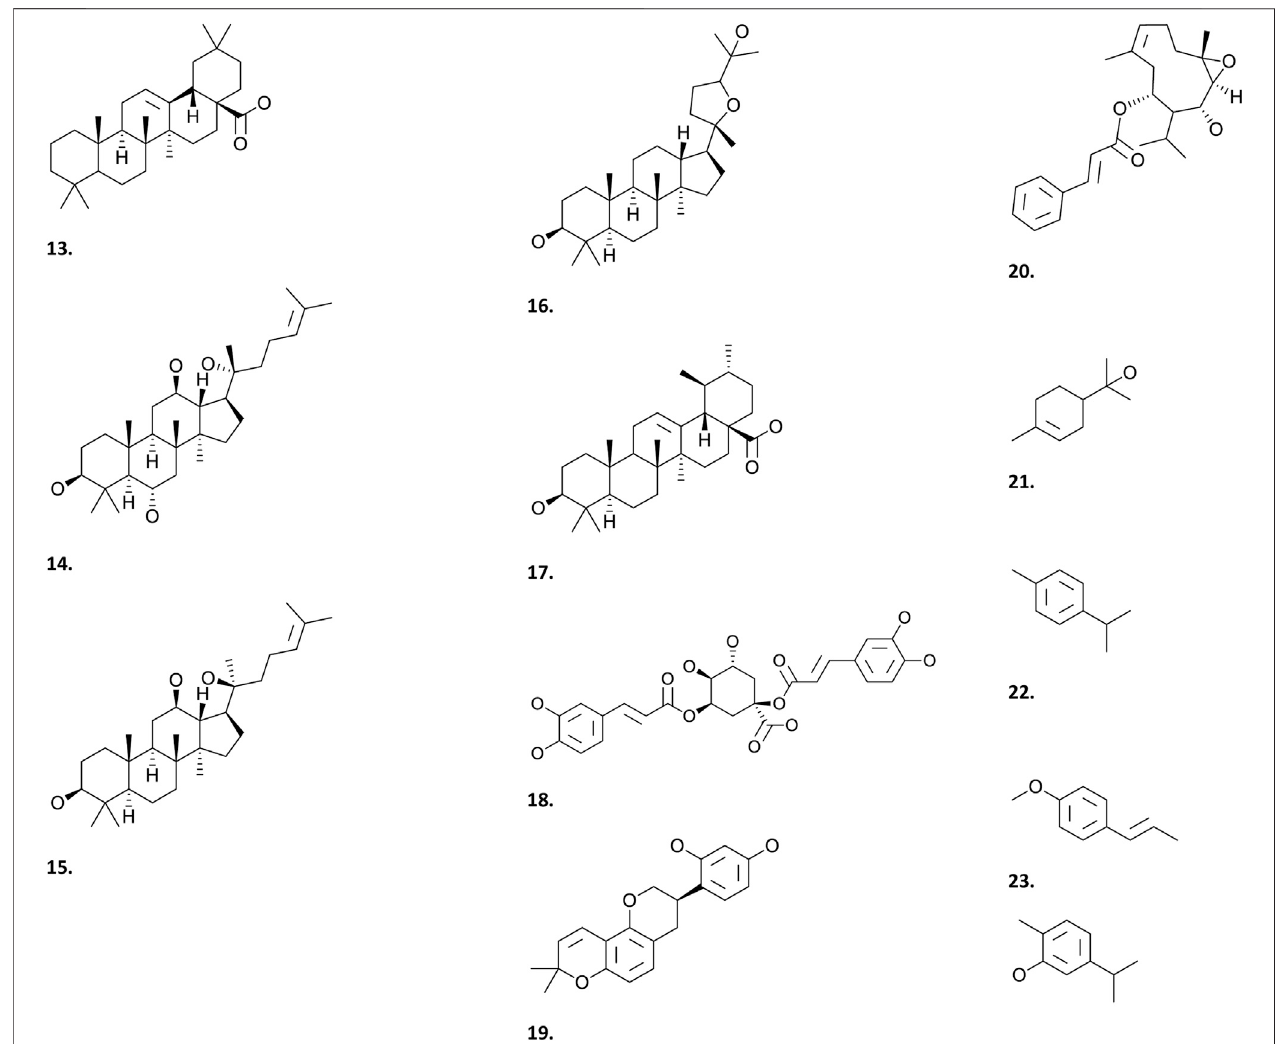
FIGURE 7 | Structures of some plant-derived secondary metabolites with antiviral activities.